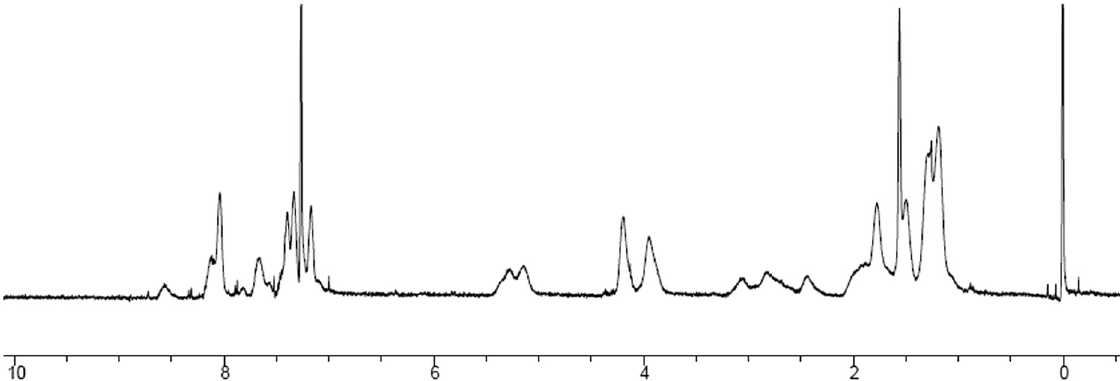
Figure 1: 1 H - NMR spectrum of polymer P1 .